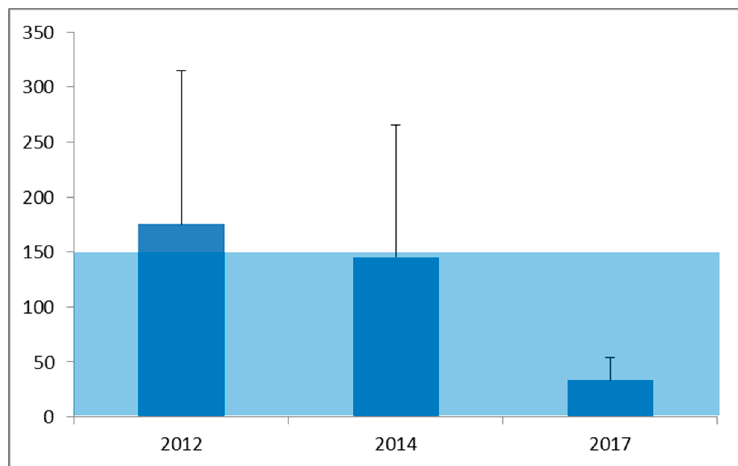
Figure 9. Mean ± sd FA concentrations (µg/m 3 ) in the breathing zone of workers and students during a full shift. The shaded area indicates the 8-h TWA OEL of 150 µg/m 3 for FA in The Netherlands.